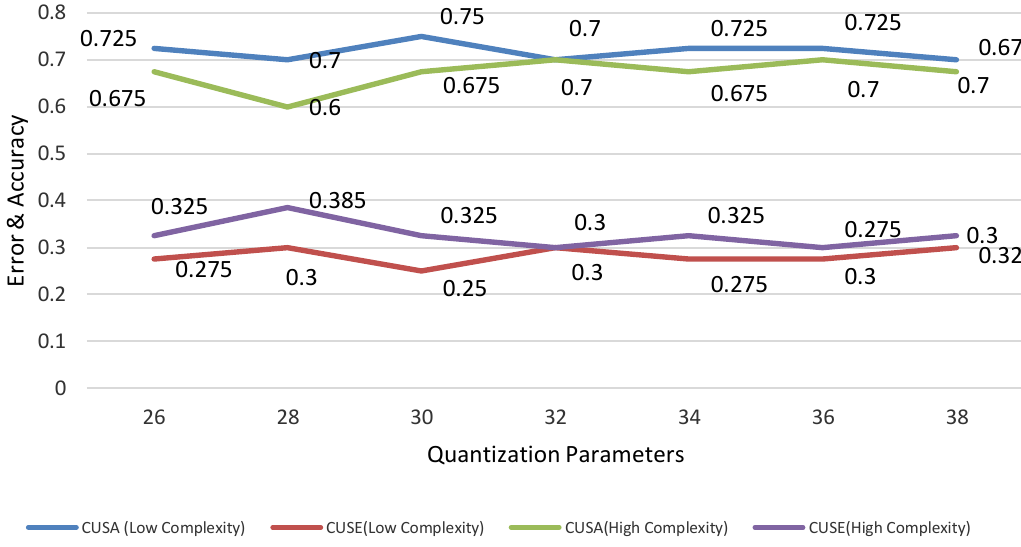
Figure 11. CUS A and CUS E variation based on encoding complexity changes in various QP (Educational).